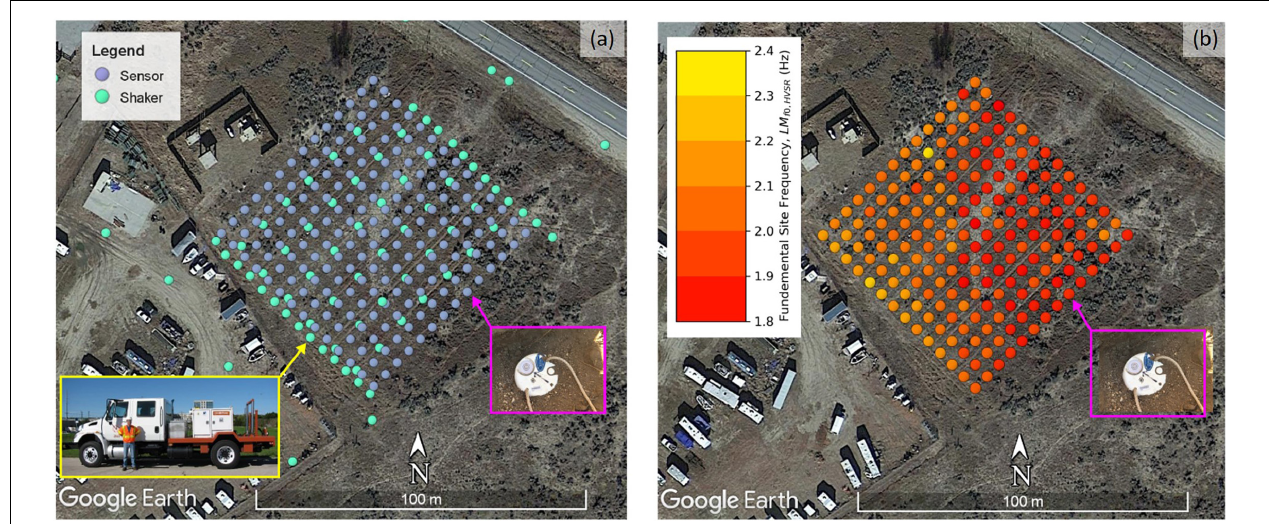
FIGURE 6 | Garner Valley Downhole Array (GVDA) site: (a) 196 3-component land seismic sensors deployed in a 65 m × 65 m array with a uniform 5-m receiver spacing and the NHERI@UTexas Thumper shaker truck that was used to generate broadband frequency sweeps at 84 locations inside and outside of the array, and (b) spatial variability in fundamental site frequency (f 0 ) indicating 3D site